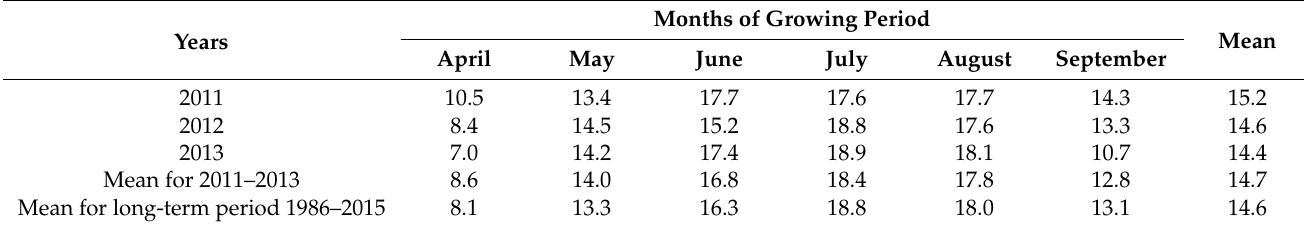
Table 2. Air temperature (°C) during the growing periods of ‘Courage’ potato (2011–2013). Years